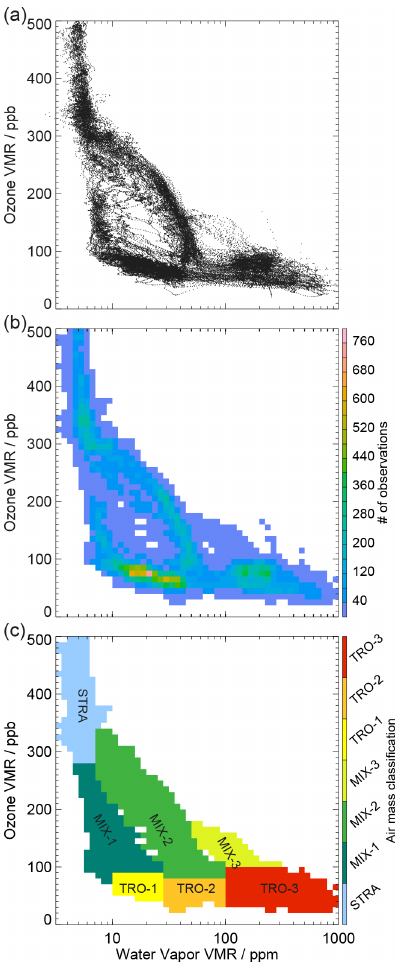
Figure 5. T–T correlation as in Fig. 4b but for mean (in colors) and standard deviation (gray contours) of (a) pressure, (b) potential temperature and (c) potential